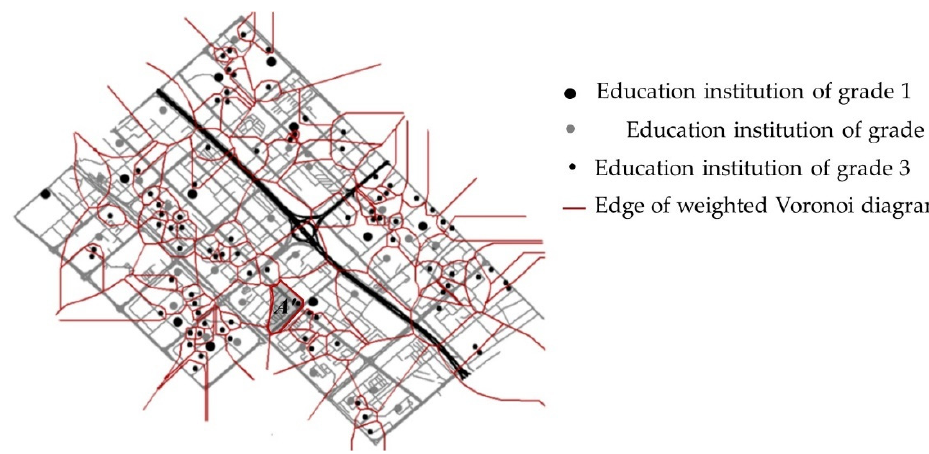
Figure 10. Weighted Voronoi diagram of points in the study area.